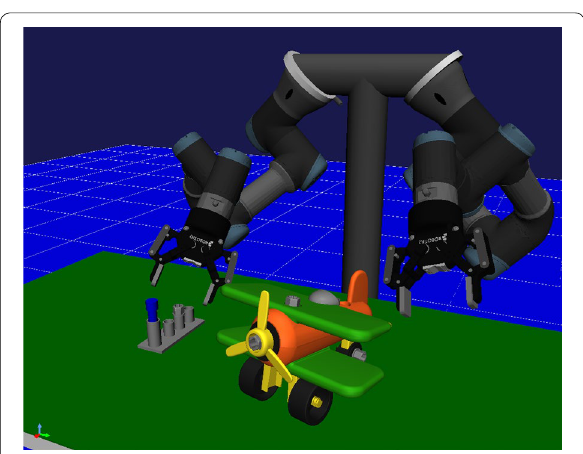
Fig. 13 Integrated 3D models for the